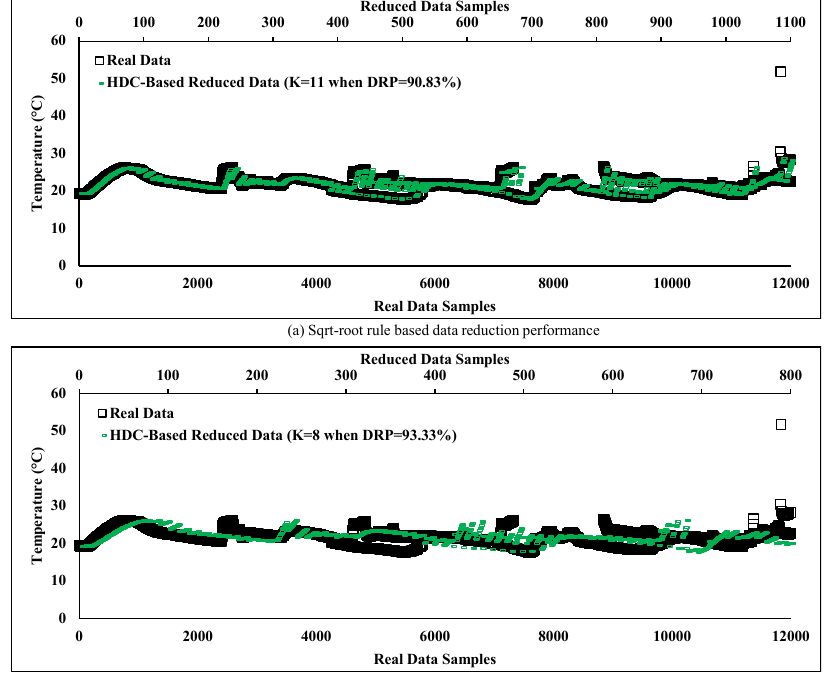
Figure 9. Performance comparison of HDC-based reduced data with real data using two different numbers of clusters. ( a ) The square-root rule (K = 11 when DRP = 90.83%); ( b ) Sturge’s rule (K = 8 when DRP = 93.33%).